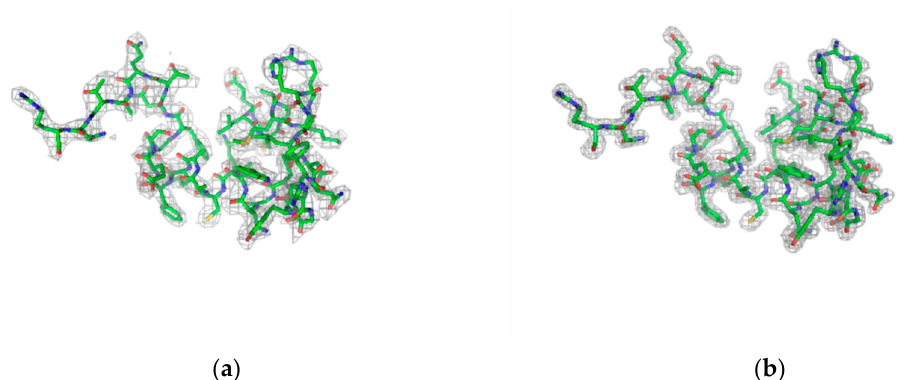
Figure 5. 2mF obs - DF calc (contoured at 1 σ ) for residues 5–45 of lysozyme ( a ) for data collected at 0.01% transmission of the incident flux (dataset L21_001) and 1 kHz frame rate ( b ) for data collected at 50% transmission of the incident flux and 1 kHz frame rate (dataset L11_50).